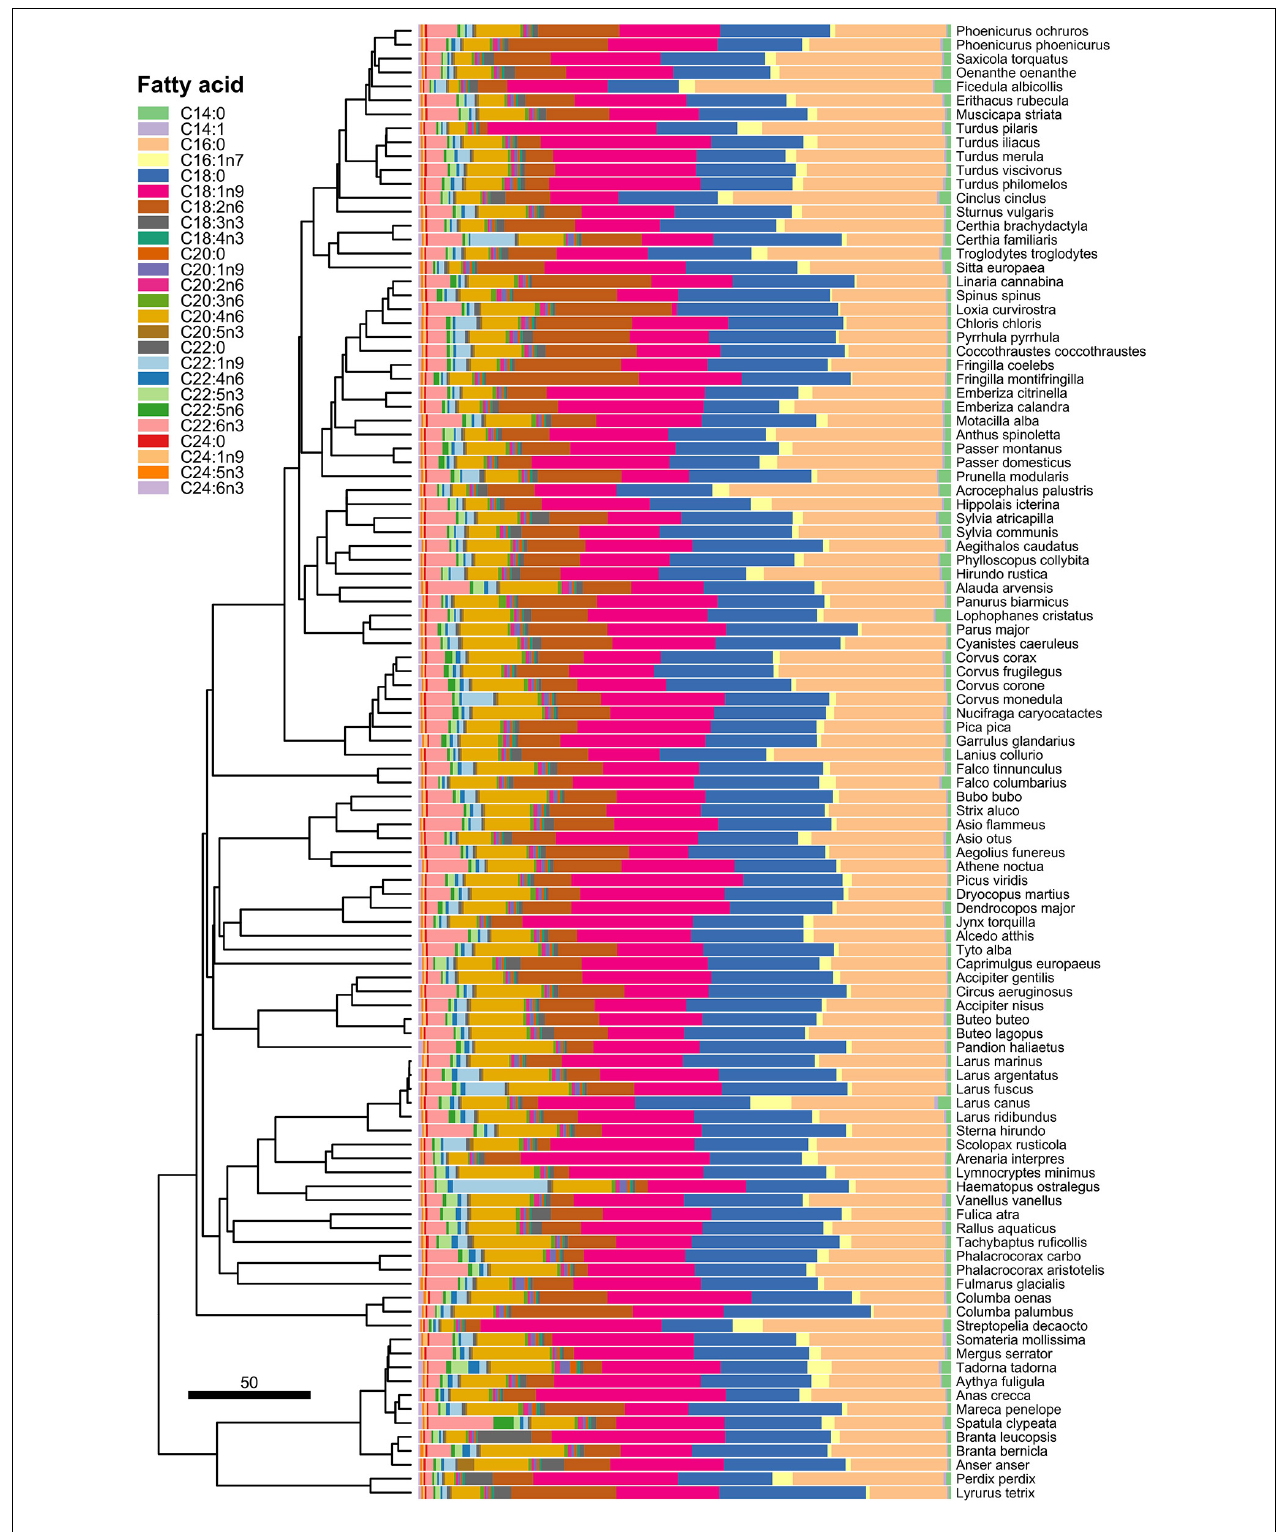
FIGURE 1 | Interspecific variation in relative proportions of the individual liver FA.